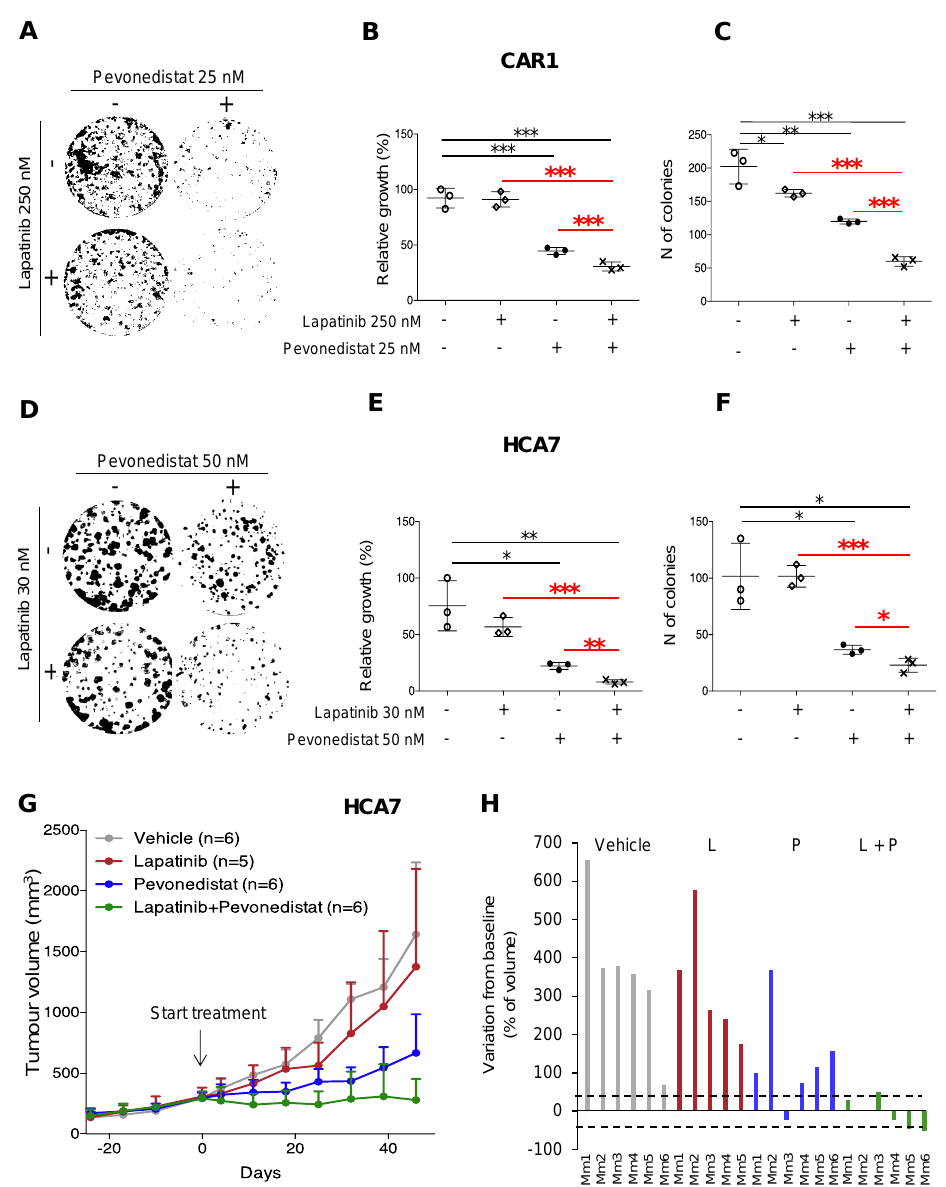
Figure 4. Combination of pevonedistat and EGFR pathway inhibition in RAS/RAF WT CRCs. ( A ) Colony formation of CAR1 cells was evaluated in response to pevonedistat (25 nM), lapatinib (250 nM), and combinatorial treatment of both. After 10 days cells were fixed by crystal violet. ( B , C ) Relative growth of CAR1 colonies ( B ) and their number ( C ) were quantified in triplicate as shown by dot plot. Significant differences among triple combination and other treatment groups (pevonedistat—P; lapatinib—L) were analyzed by applying a Student t test (*: p < 0.05; **: p < 0.01; ***: p < 0.001; the red color highlights comparisons between combined and single treatments). ( D ) Colony formation of HCA7 cells was evaluated in response to pevonedistat (50 nM), lapatinib (30 nM), and combinatorial treatment of both. After 13 days, cells were fixed by crystal violet. ( E , F ) Relative growth of HCA7 colonies ( E ) and their number ( F ) were quantified in triplicate, as shown by the dot plot. Significant differences among triple combination and other treatment groups (pevonedistat—P; lapatinib—L) were analyzed by applying a Student t test (*: p < 0.05; **: p < 0.01; ***: p < 0.001; the red color highlights comparisons between combined and single treatments). ( G ) Mice transplanted with HCA7 cells were treated for around 7 weeks with single or combinatorial agents (pevonedistat 90 mg/kg; lapatinib 100 mg/kg). Tumors were measured weekly, and growth was reported as mean ± SD. ( H ) Waterfall plot for treatment response compared with tumor volume at baseline in each mouse (Mm) of respective group of treatment. The dotted line represents the cut-off values for therapy response indicated as >35% for progression and 35 ≤ % ≤ − 50 as tumor